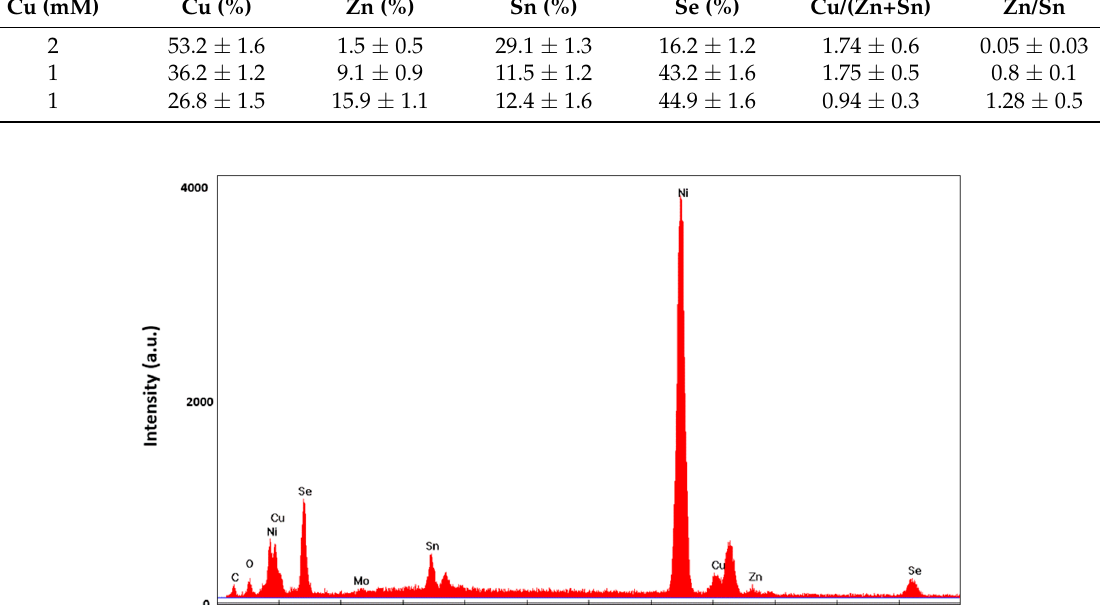
Table 1. Composition of as-deposited CZTSe NWs obtained in different electrochemical conditions. pH Cu (mM)